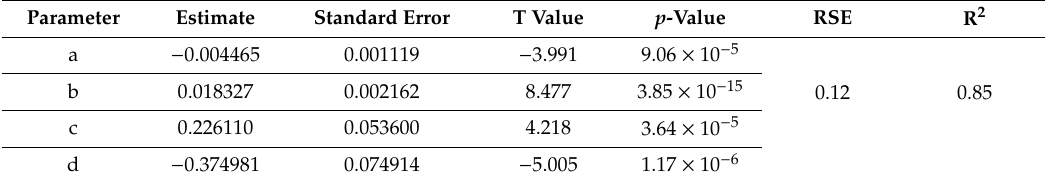
Table 2. Coefficients of Equation (3) for estimating the relation between periodic production (PAI).